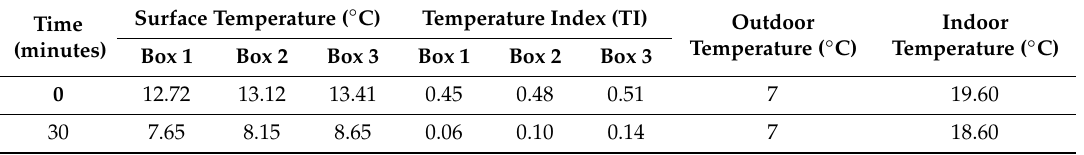
Table 5. Variation of the temperature index (TI) over the time ( ∆ P = 60